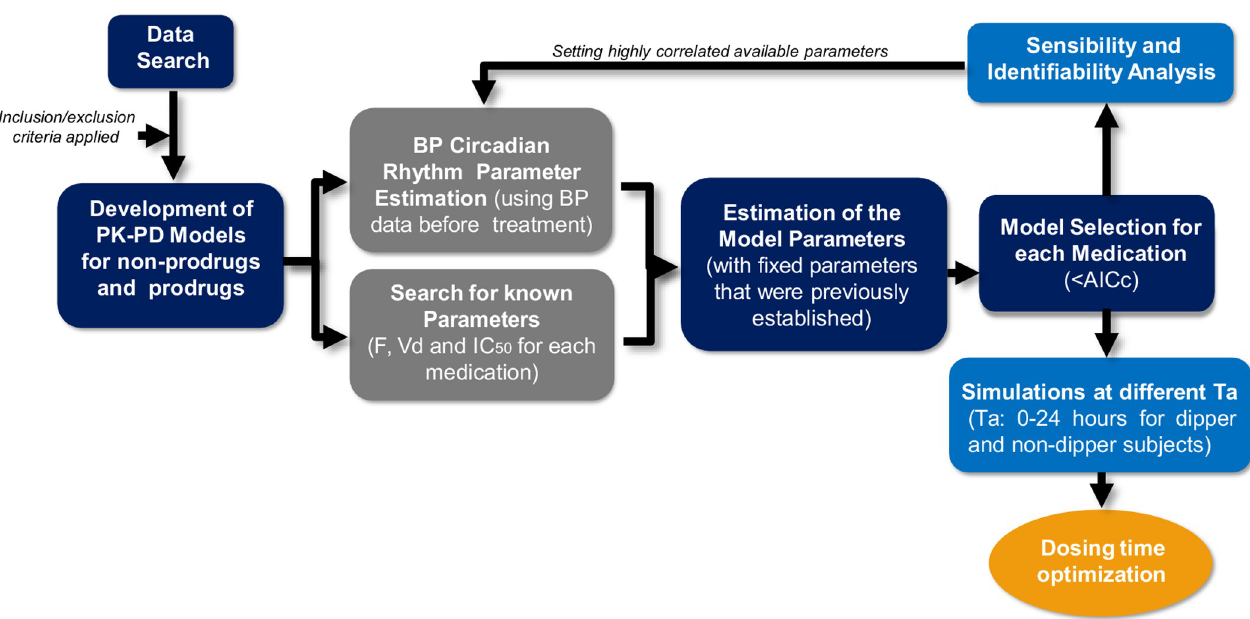
Fig 1. Summary scheme of the methodology employed. Inclusion and exclusion criteria and PK-PD models developed are described in the methodology section (data search and selection and PK-PD modeling sections, respectively). Preliminarily, local sensitivity and identifiability analyses of the developed PK-PD models indicated the presence of highly correlated parameters, so the circadian rhythm parameters of BP were estimated, and available pharmacokinetic parameters were also established; F (bioavailability), Vd (volume of distribution) and IC 50 (50% inhibitory concentration). Thus, the remaining parameters of each model were estimated later. Models that include and do not include circadian kinetic constants and Hill’s coefficient in the effect equation were tested, and the model with the lowest corrected Akaike information criterion ( AICc ) was selected. Subsequently, the selected model parameters were subjected to an analysis of local sensitivity and identifiability in order to understand their relevance. Finally, simulations at different administration times ( Ta ) allowed establishing relationships between different optimization objectives and proposing optimal administration times for dipper and non-dipper subjects.